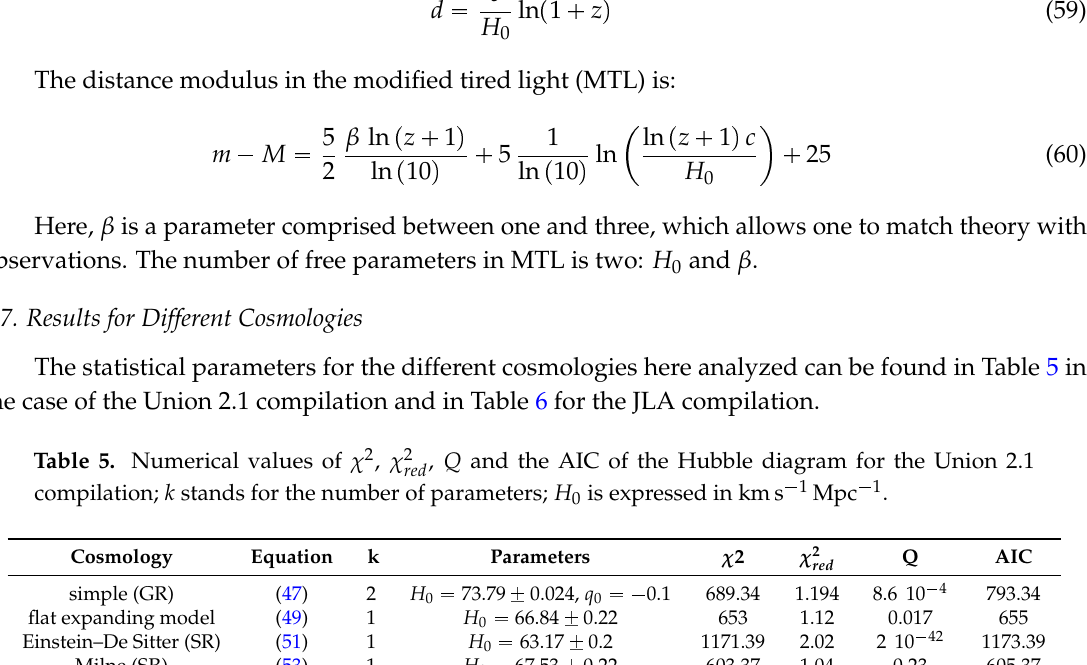
, Q and the AIC of the Hubble diagram for the JLA compilation; k red